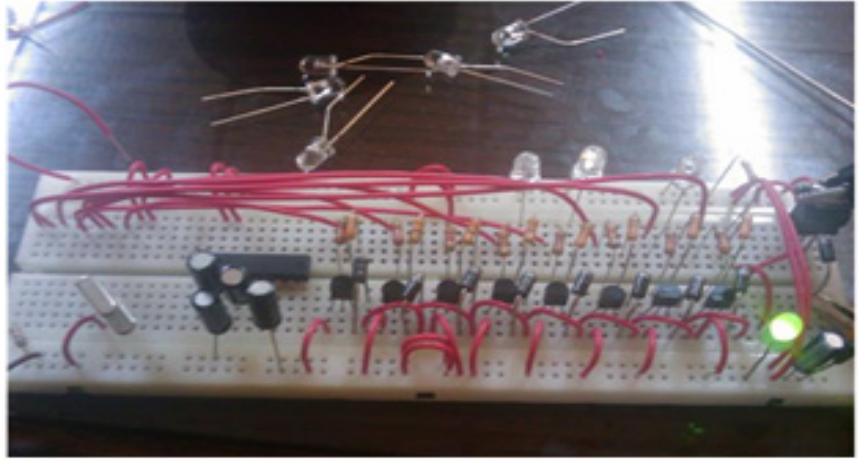
Fig. 7. Components and Circuit